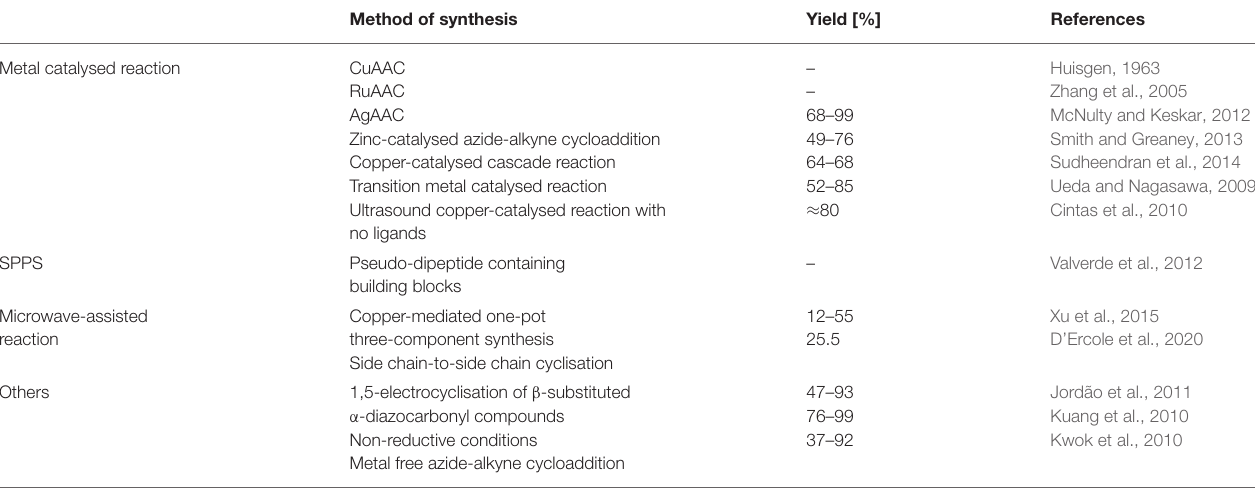
TABLE 1 | Synthetic techniques to obtain molecular structures containing triazolyl moieties reported in this review.